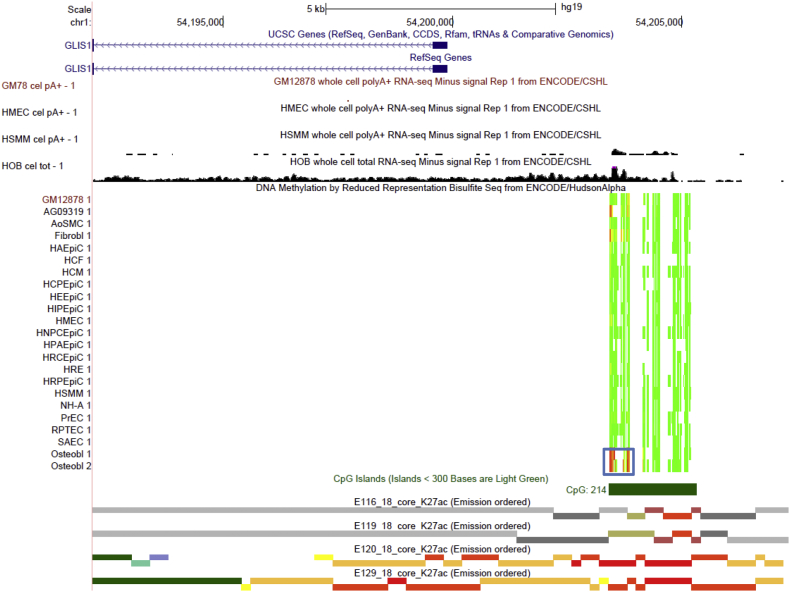
Osteoblastic hypermethylation at GLIS1 TSS surrounding region. The same tracks as illustrated in Fig. 3 are shown using the UCSC Genome Browser (http://genome.ucsc.edu, version hg19). Osteoblast-specific DMRs are highlighted in the blue box.